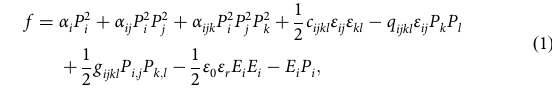
and out-of-plane modes) to record the ferroelectric domain structure. Pt con- ductive tips with a force constant of 10 Nm − 1 (RMN-25PT400B) were used for piezoresponse force microscopy measurement. Since in-plane (IP) PFM only measures the component perpendicular to the cantilever axis, which is associated with the torsional vibration of the cantilever, we gathered the real part images of IP PFM signals measured at different probe orientations to construct a full vector map of the IP piezoresponse vector.